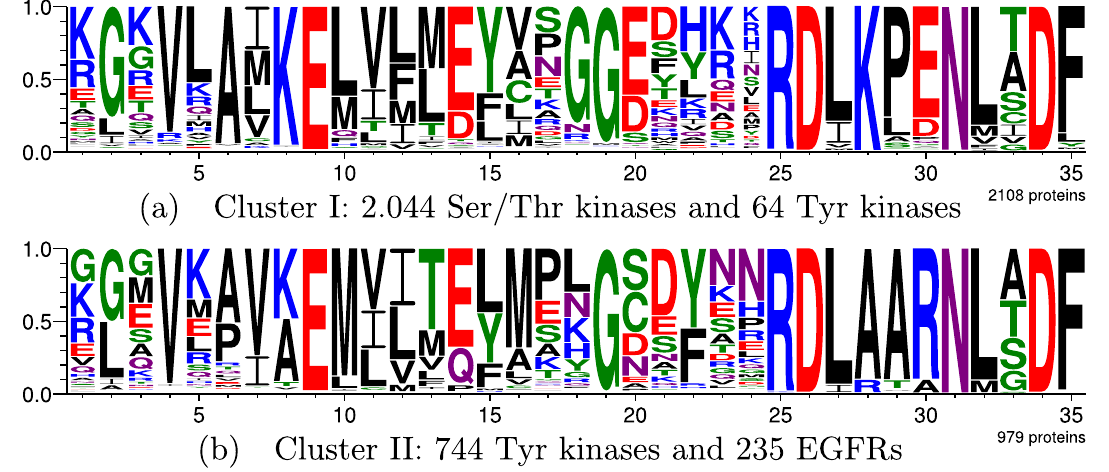
Fig 5. Protein kinase division into two clusters by the GP system. Subfigure (a) shows the active site logo for the cluster consisting mainly of Ser/Thr kinases, while (b) shows the logo for the cluster of Tyr kinases combined with the EGFR